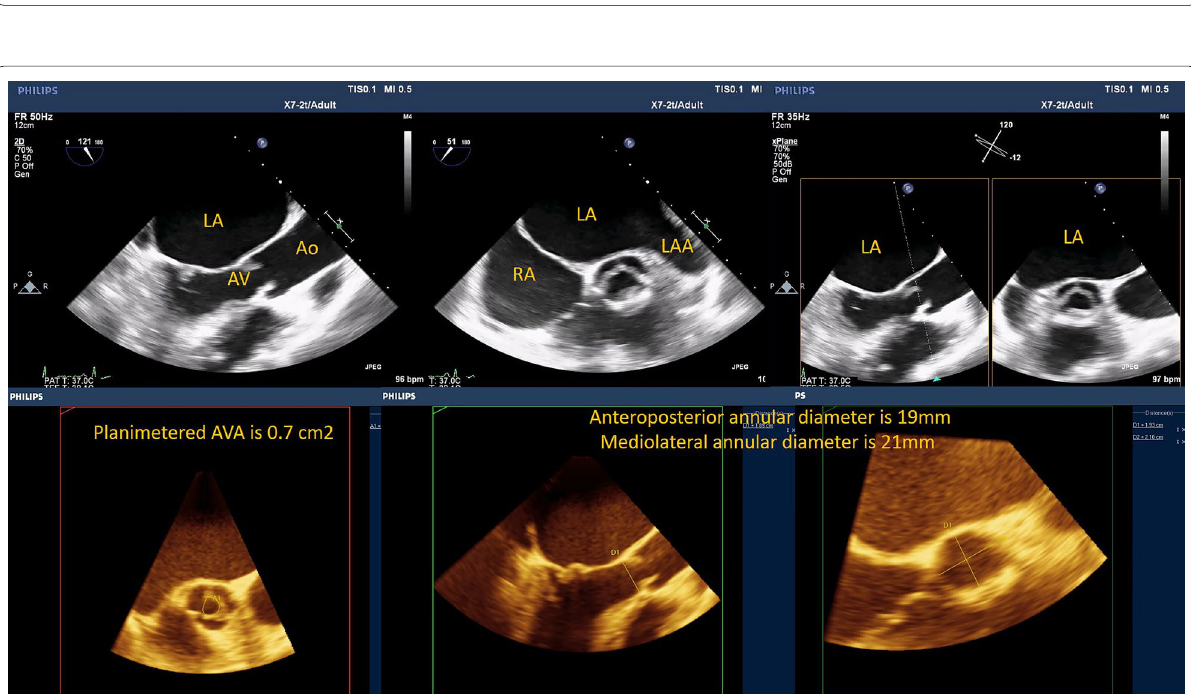
Fig. 8 A case of rheumatic aortic valve disease. 2D TOE (aortic long‑ and short‑axis views) shows reduced excursion of the cusps with characteristic doming. X‑plane mode of the aortic valve at the level of its tips to get the true anatomical orifice. Multiplanar reformatting (MPR) of the 3D volume of the aortic valve and LVOT; accurate planimetered AVA and the anteroposterior and mediolateral diameters of the aortic